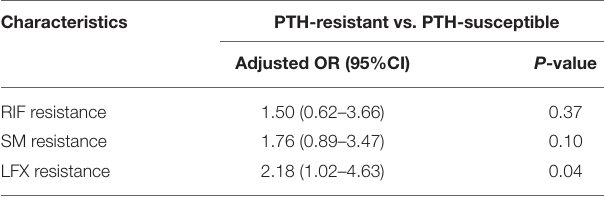
TABLE 3 | Multivariable analysis for factors associated with PTH